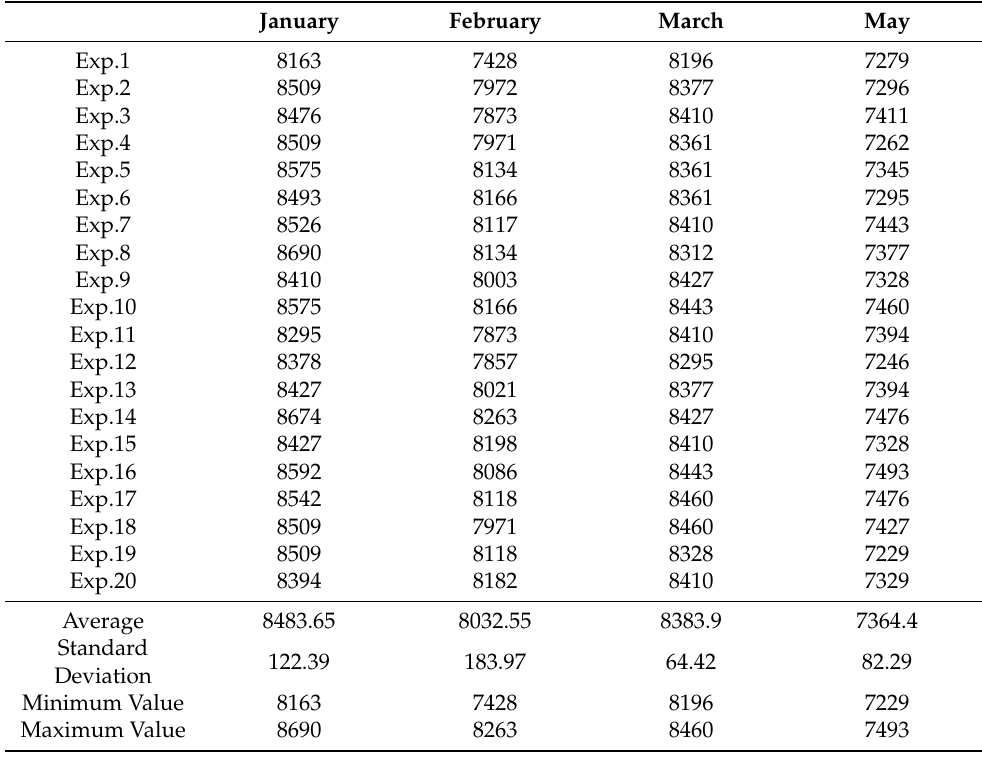
Table 5. Simulated production data for months analyzed.